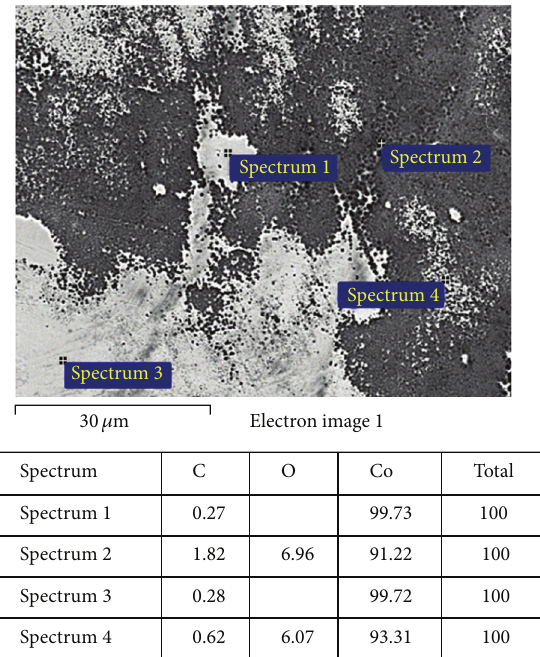
Figure 3: SEM/EDS of the nano-Co-coated Ni sheet after corrosion tests in 0.1M NaCl solution.